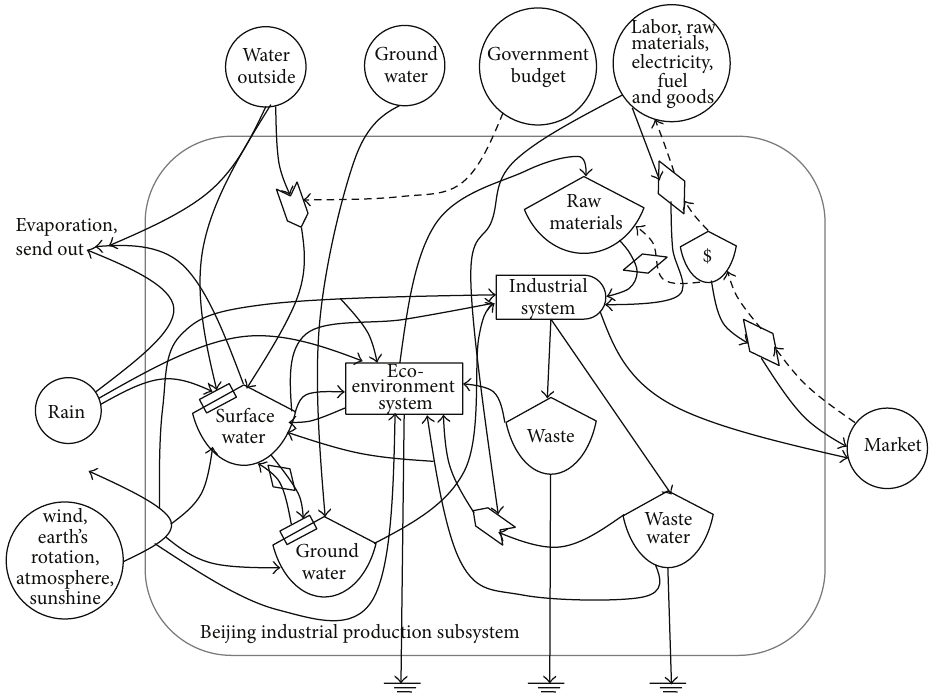
Figure 4: Figure of energy flows for Beijing industrial subsystem network. Table 5: The water resource contribution rate and value of Beijing industry system (2008–2012) (unit: 10 20 sej).